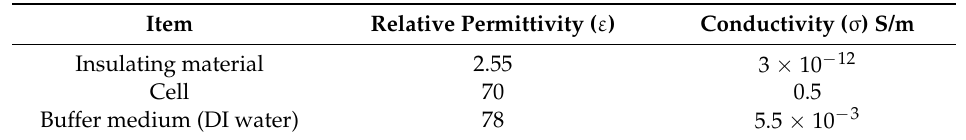
Table 1. Parameter constants of material and samples.